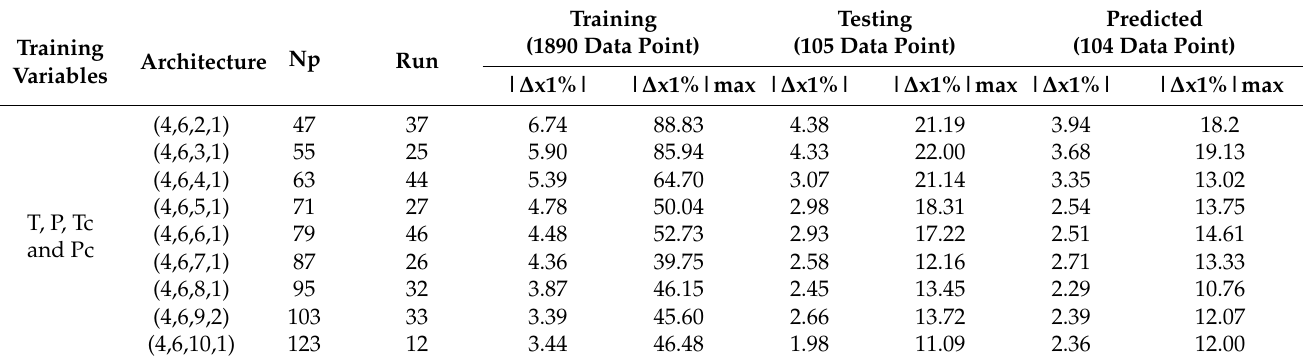
Table 4. Results of the 6,n,1 architecture using T, P, Tc and Pc training variables in step 2 (Np: parameters number).